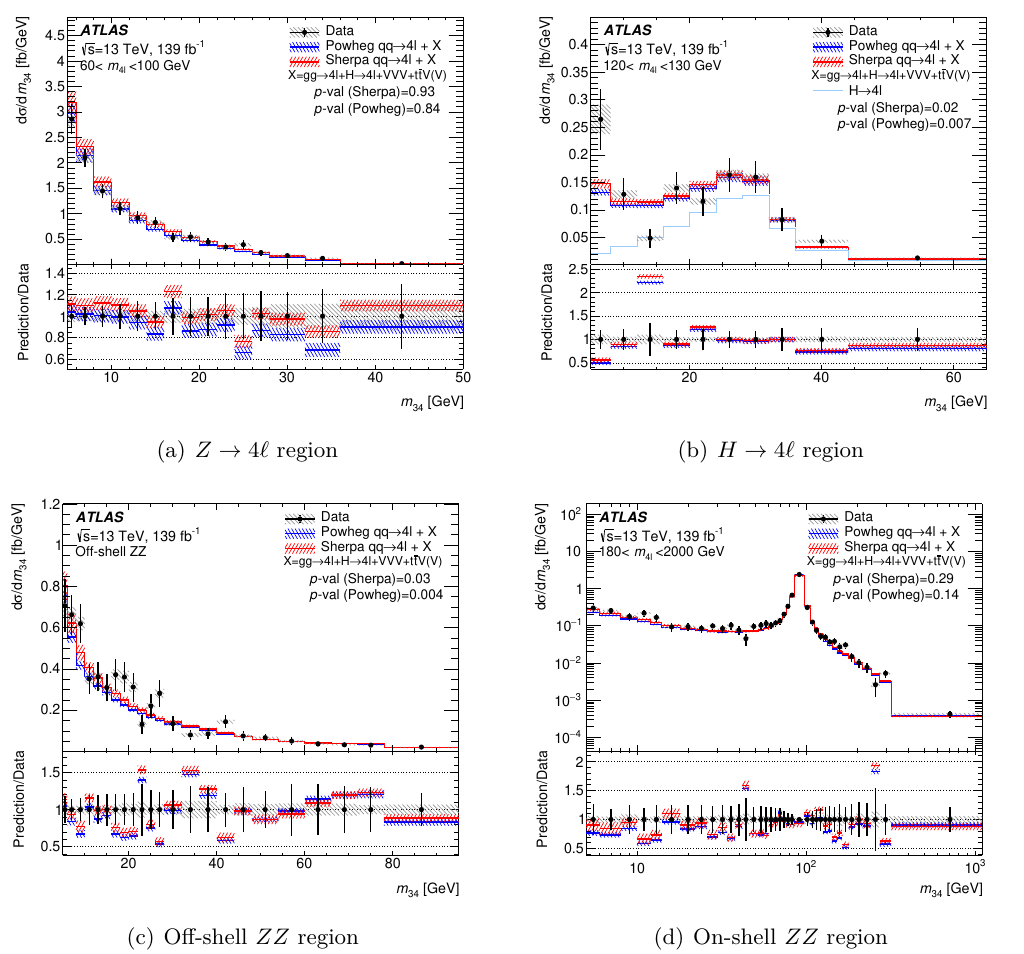
Figure 7 . Differential cross-section as a function of m 34 in the four m 4 ‘ regions. The measured data (black points) are compared with the SM prediction using either Sherpa (red, with red hashed band for the uncertainty) or Powheg + Pythia8 (blue, with blue hashed band for the uncertainty) to model the q ¯ q → 4 ‘ contribution. In (b) the contribution from Higgs production is shown in addition to the total SM prediction. The error bars on the data points give the total uncertainty and the grey hashed band gives the systematic uncertainty. The p -value is the probability for the χ 2 , with the number of degrees of freedom equal to the number of bins in the distribution, to have at least the observed value, given the SM prediction. The lower panel shows the ratio of the SM predictions to the